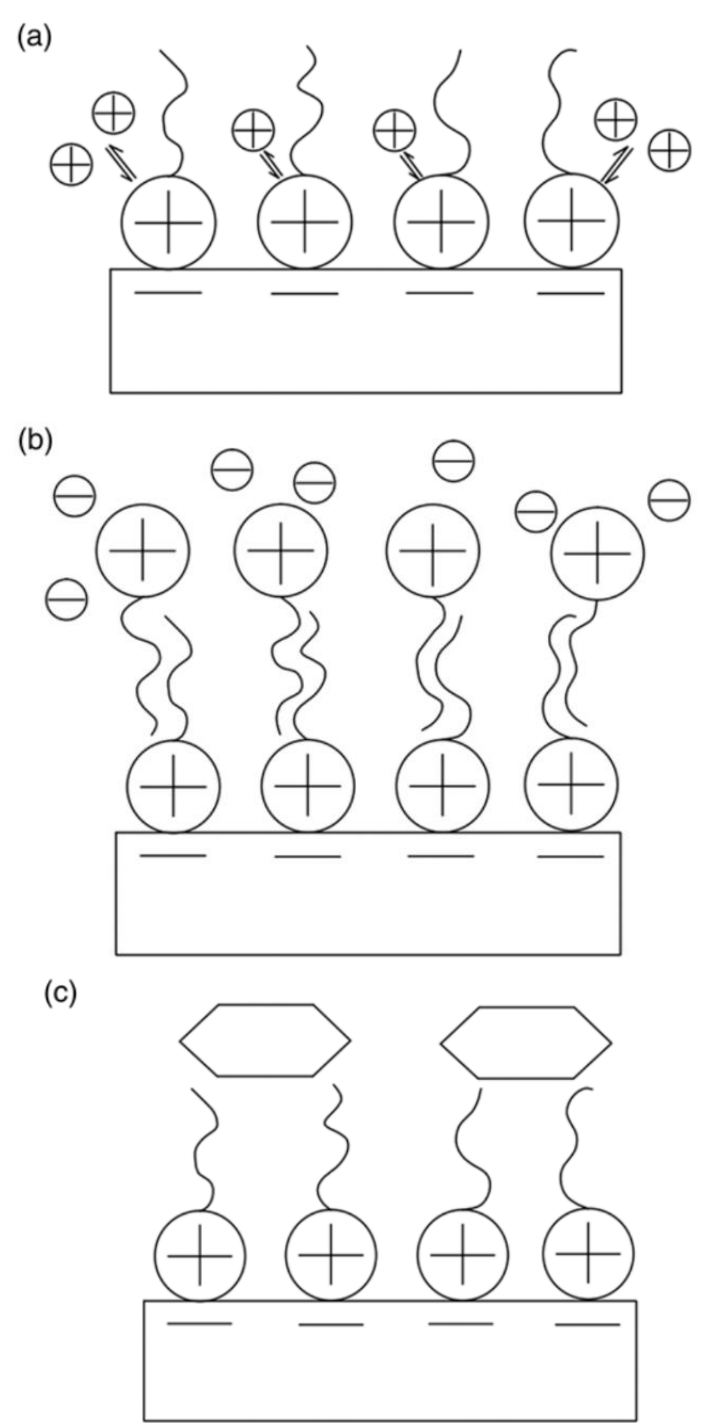
Figure 10. The cationic surfactant on surface of zeolite can remove cation ion ( a ), anion ion ( b ), and organic ion ( c ) [50].